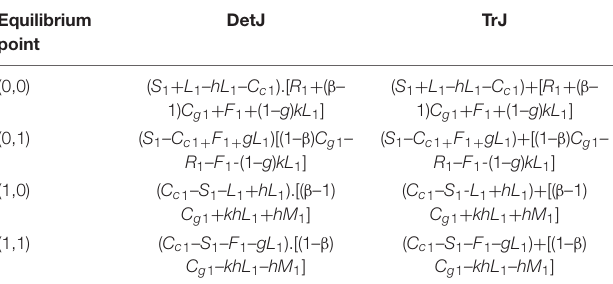
TABLE 2 | The formula of the determinant for each equilibrium point. Equilibrium DetJ point